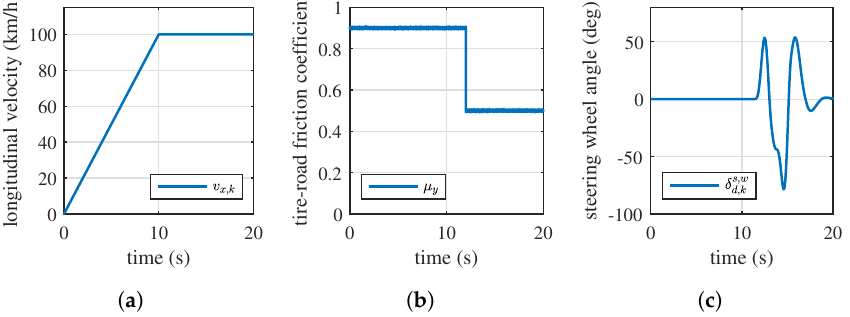
Figure 7. Vehicle open–loop behavior. ( a ) Vehicle longitudinal velocity v x , k . ( b ) Tire–road friction coefficient µ y , k . ( c ) Driver steering wheel angle δ s , w